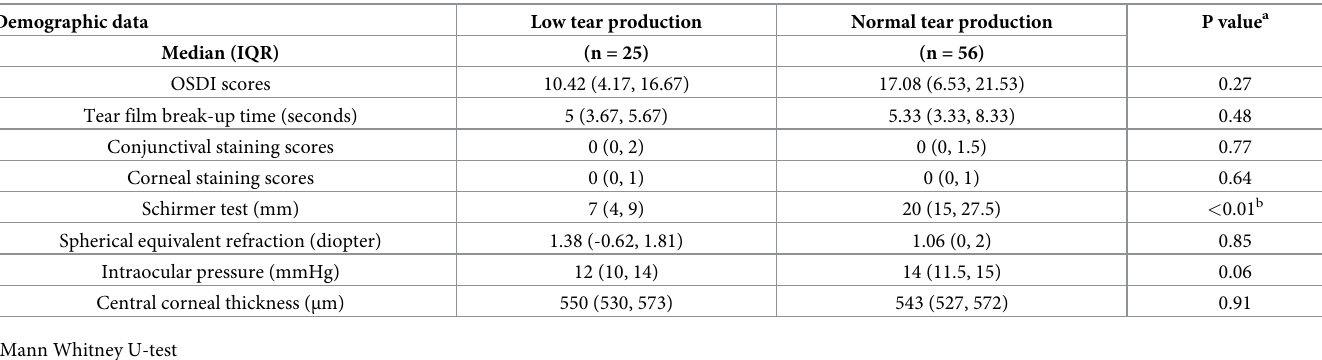
Table 2. Demographic data of the low and normal tear production